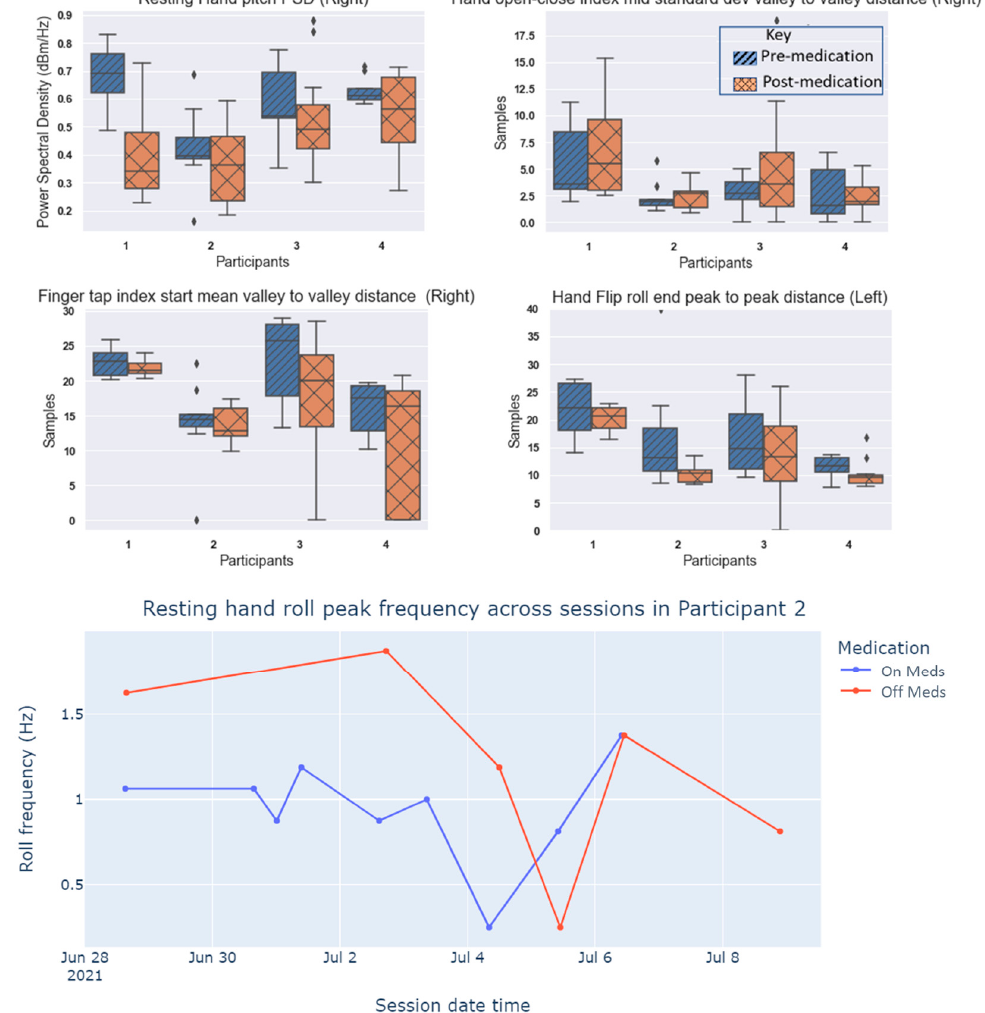
Figure 10. ( Top ) Box plot of features from iTex gloves across participants for pre- and post-medication states. ( Bottom ) Line chart showing resting hand roll peak frequency across sessions for Participant 2.